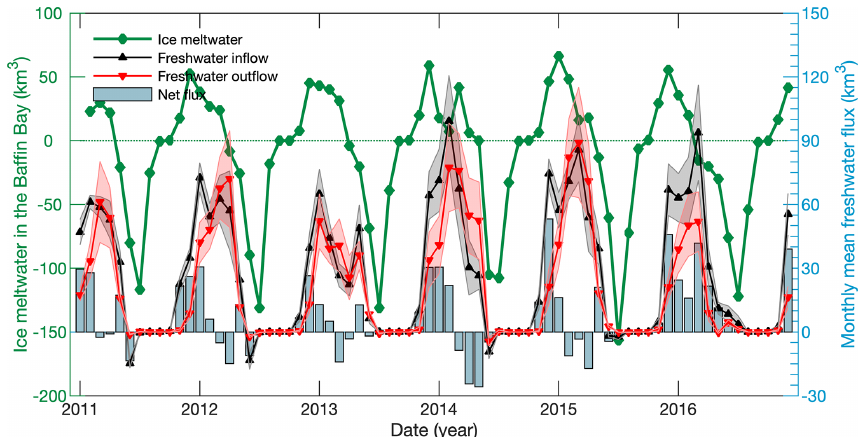
Figure 8. Freshwater from sea-ice inflow (black line) through the north gate and outflow (red line) through the south gate (Davis Strait), and sea-ice growth and melting (green line) in the Baffin Bay. The net flux of freshwater derived from net SIV flux (i.e., sea-ice inflow minus outflow) is presented in the sky-blue